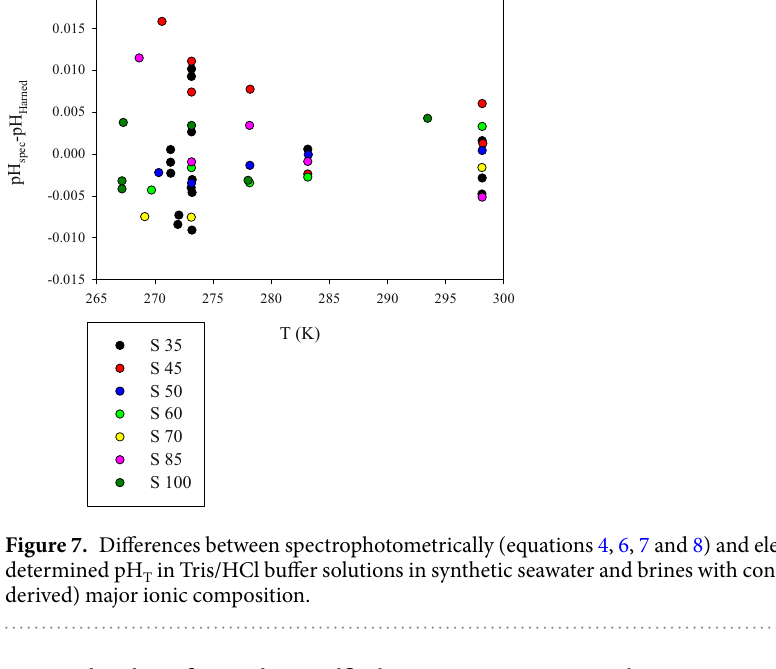
Determination of pH using purified m CP at temperatures between 298.15 K and the freezing point of seawater and sea-ice brines up to salinity 100. seawater brines, with conservative major ionic composition, with S between 30 and 100 and T between freezing point and 298.15 K. The residuals (pH spec –pH Harned ) of pH measurements in Tris/HCl buffers using purified m CP and application of eq. 4, 6, 7 and 8 indicate a relatively wide spread (Fig. 7) with an average absolute residual of 0.004 and maximum absolute residual of 0.016. As the analytical precision (1 standard deviation of n = 5–10 ) T 2 2 , σ fit = 0.007) and random error related to buffer preparation, bottling, and handling. Residuals are up to 3 times larger close to the freezing point than at 298.15 K possibly due to the physical/optical